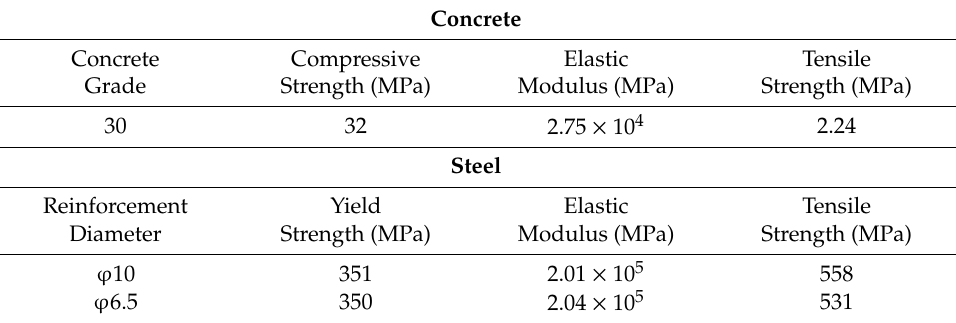
Figure 5. Constitutive relationship: ( a ) the concrete ( b ) the steel bar. Table 2. Parameters of the specimen materials.